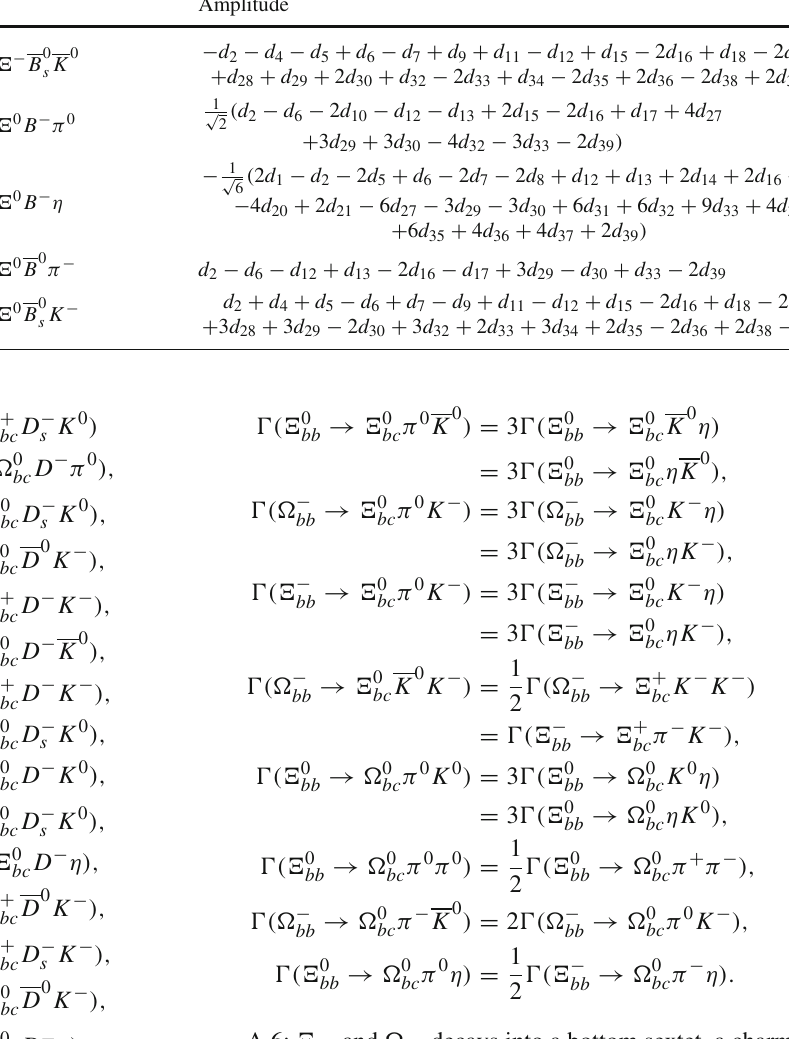
A.6: (cid:2) bb and (cid:5) bb decays into a bottom sextet, a charmed meson and a light meson